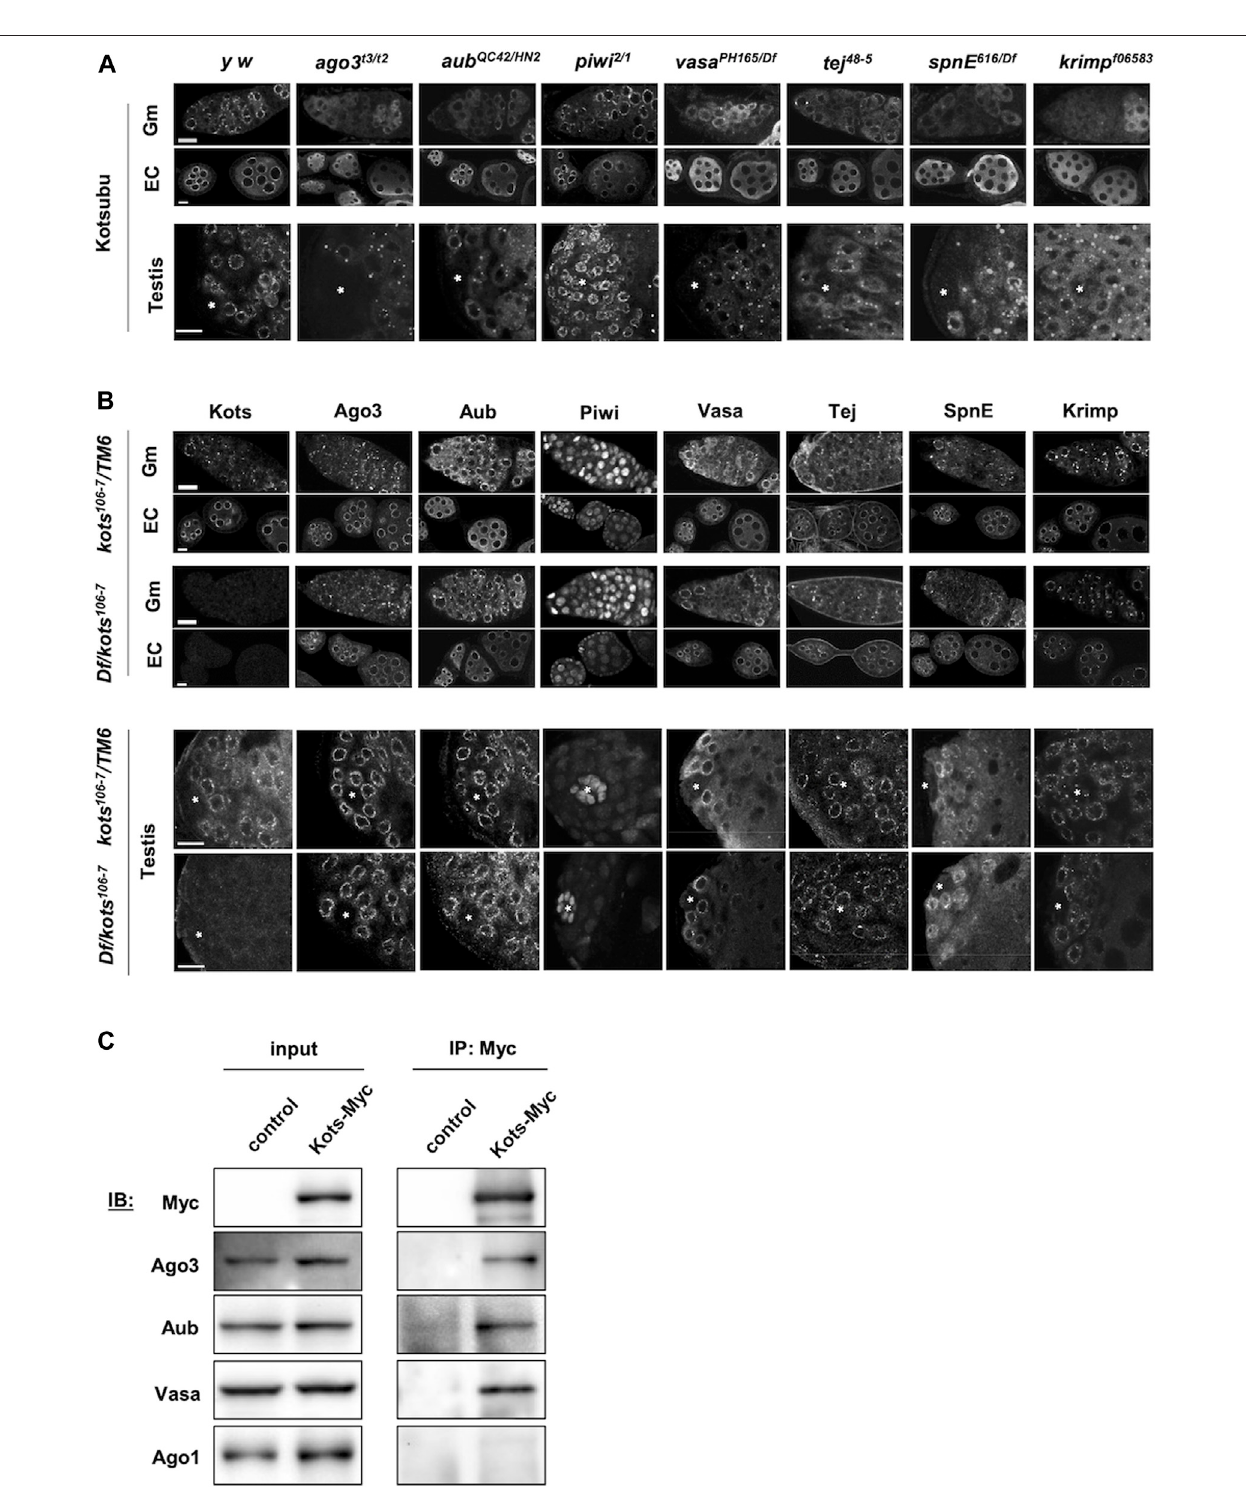
FIGURE 3 | kots interacts genetically and physically with components of the piRNA pathway. (A) Immunostaining of Kots in piRNA pathway mutant ovaries (top panel: germaria, Gm; egg chambers, EC) and testes (bottom panel). Asterisks indicate the testicular hub at the apical region. All scale bars are 10 μ m. (B) Immunostaining of piRNA pathwaycomponentsin kots mutantovariesandtestes.Allscalebarsare10 μ m. (C) ImmunoprecipitationofKots-Mycexpressedingermlinecellsinovaries. NGT40 ; nos-Gal4- VP16 was used to drive the expression of UASp- kots-Myc . Western blots (IB) detecting piRNA pathway components showing co-precipitation of two PIWI family proteins involved in the ping-pong cycle and Vasa but not miRNA pathway factor, Ago1. y w ovaries devoid of UASp- kots-Myc transgene were used as the control.